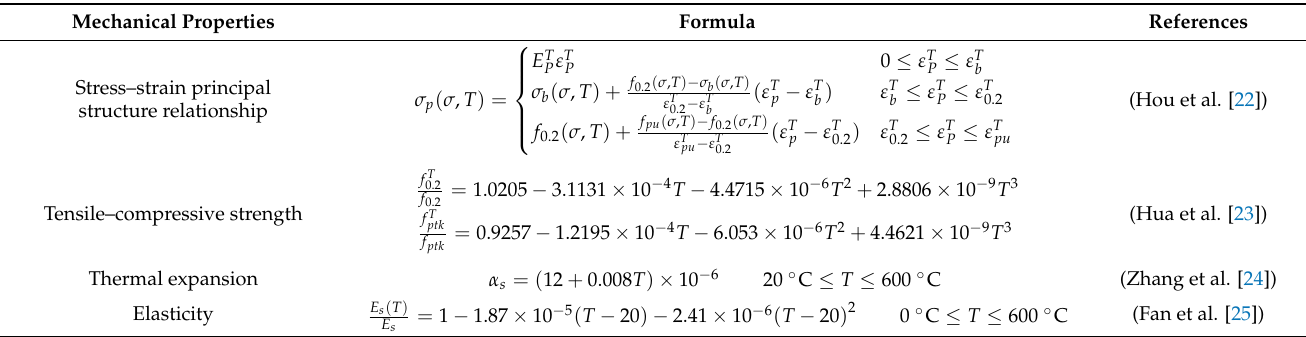
Table 5. Mechanical properties of prestressing bar at elevated